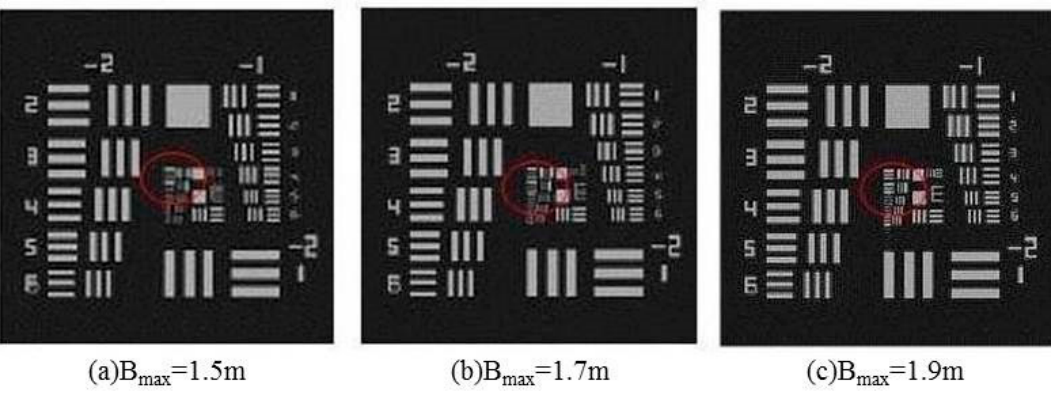
Figure 4. ( a ) Image obtained when B max = 1.5 m; ( b ) Image obtained when B max = 1.7 m; ( c ) Image obtained when B max = 1.9 m.